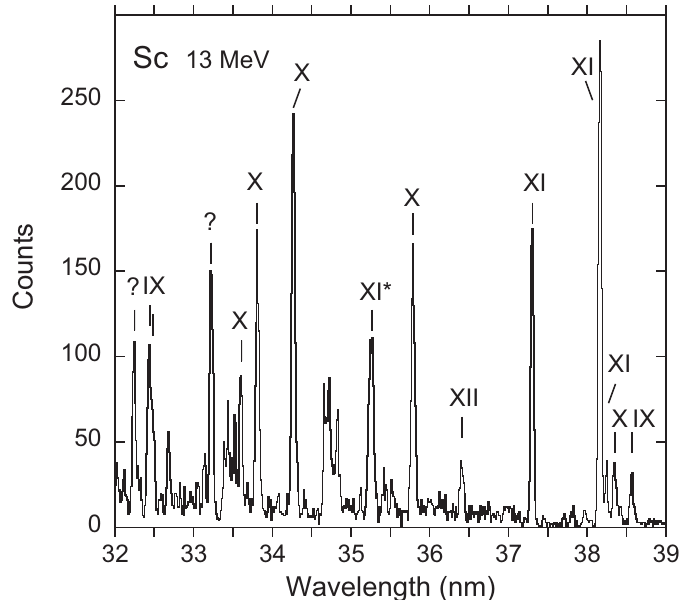
Figure 3. Beam-foil spectrum of 45 Sc recorded at an ion beam energy of 13MeV, near the optimum ion beam energy for the production of the ScXI spectrum [74]: Line width (FWHM) is 0.045 nm. The more prominent ones among the lines are labeled by the spectrum number [75]. Near 37.3 nm and 38.15 nm lie the prominent and well-known 3p–3d transitions of singly excited ScXI. The ScXI* line of present interest at λ ≈ 35.2 nm appears slightly broader than the other lines, so that a line blend has to be suspected, which enlarges the uncertainty of the wavelength